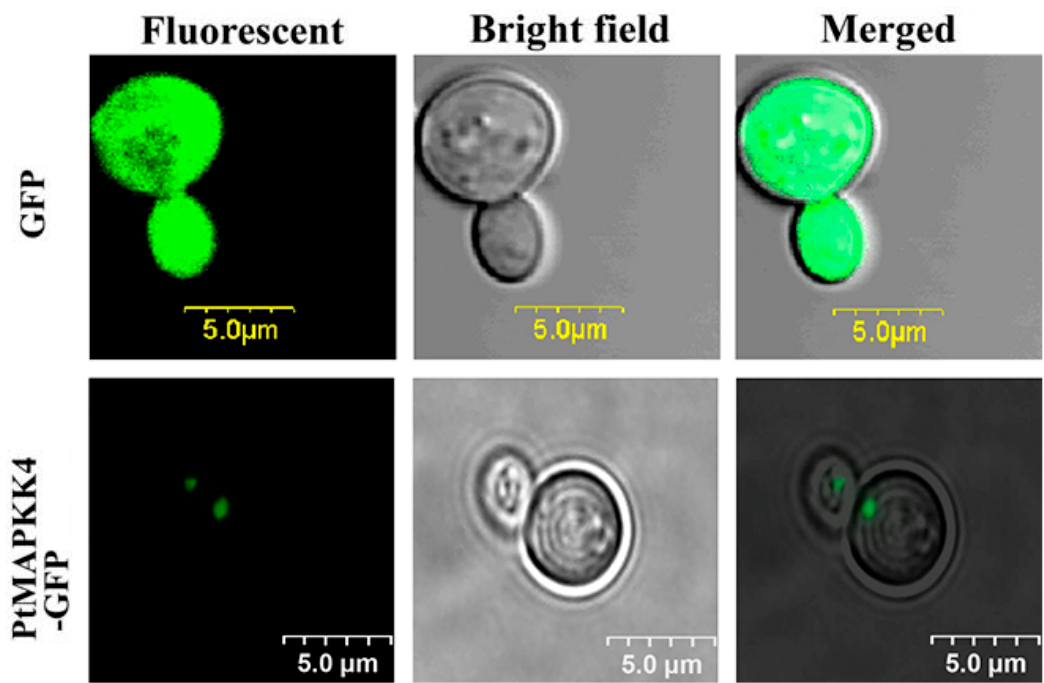
Figure 3. Subcellular localization of PtMAPKK4 under Fluorescent, Bright and Merged vision. GFP: green fluorescent protein.